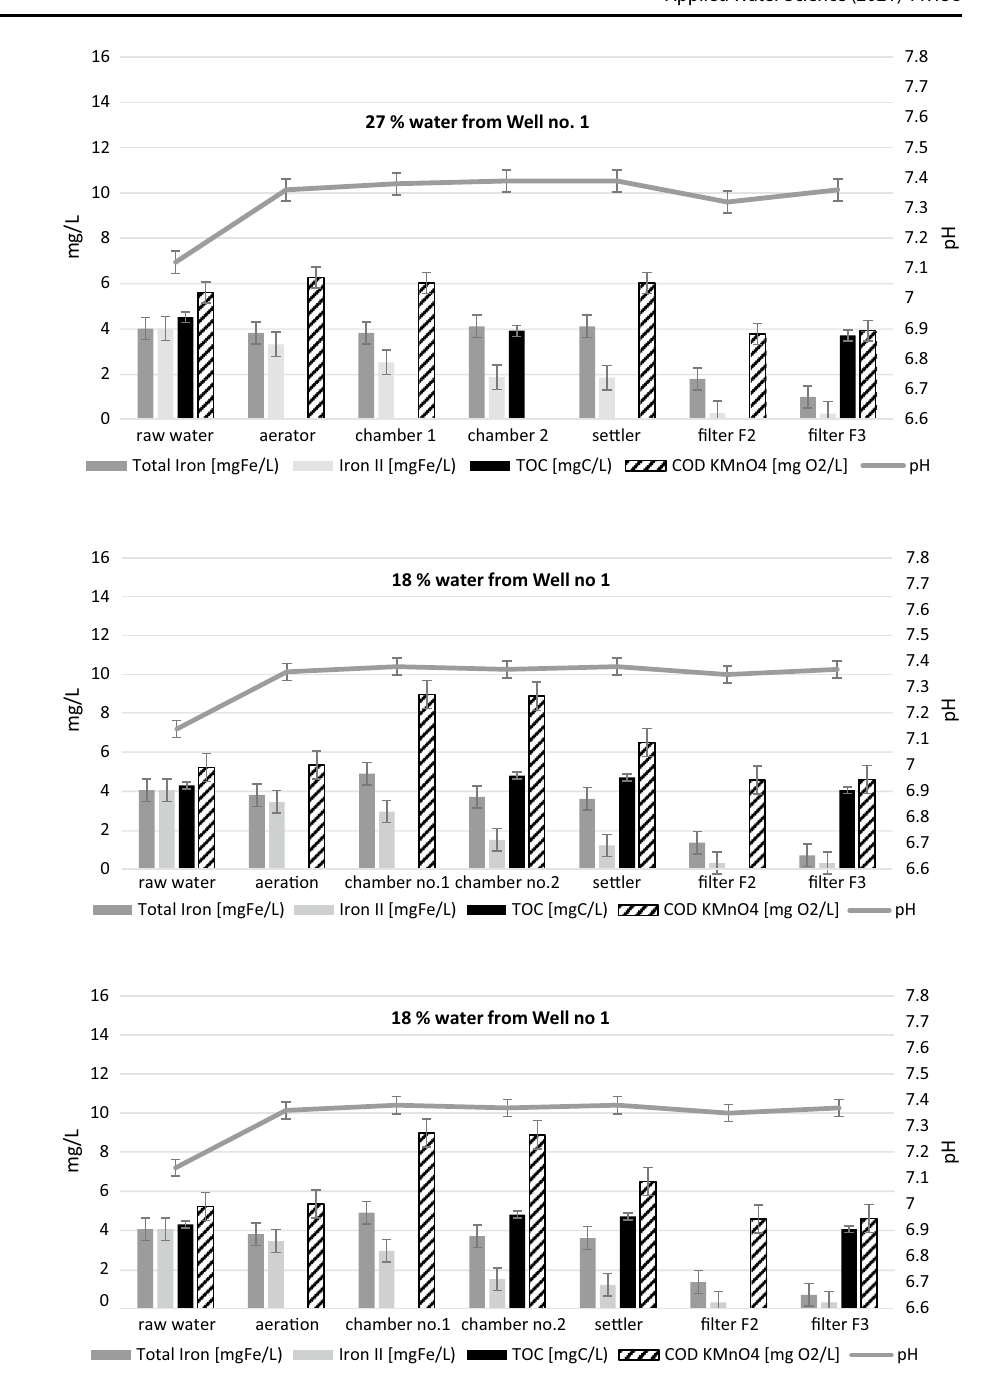
Fig. 6 Changes in the COD KMnO 4, TOC, iron and pH of water from well no. 2 during its treatment in technological processes of the pilot WTP